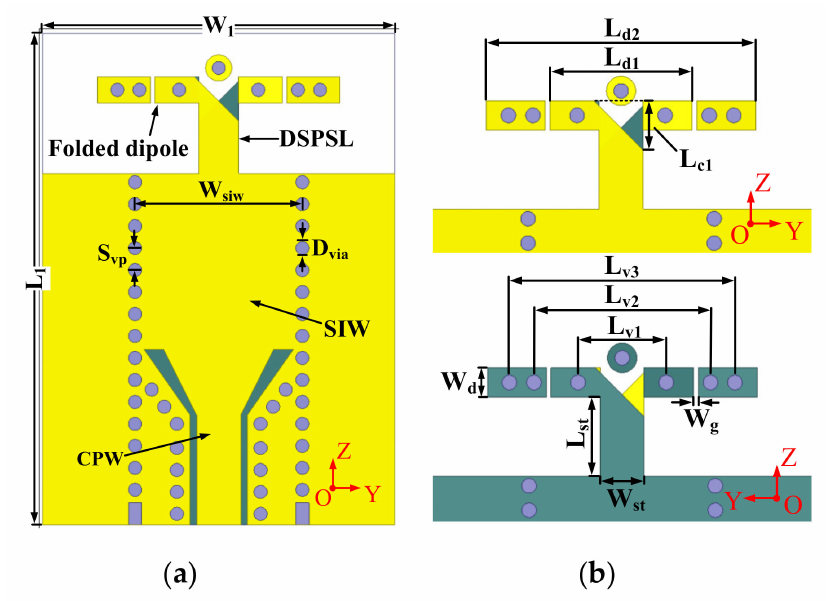
Figure 1. ( a ) Configuration of the proposed SIW-fed folded dipole antenna ( b ) top view and bottom view of the folded